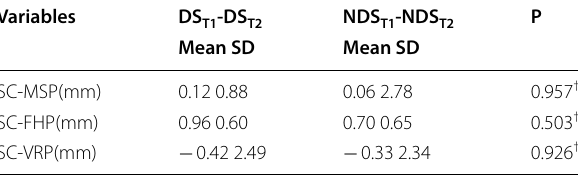
DS, deviated side; NDS, non-deviated side; †paired t test